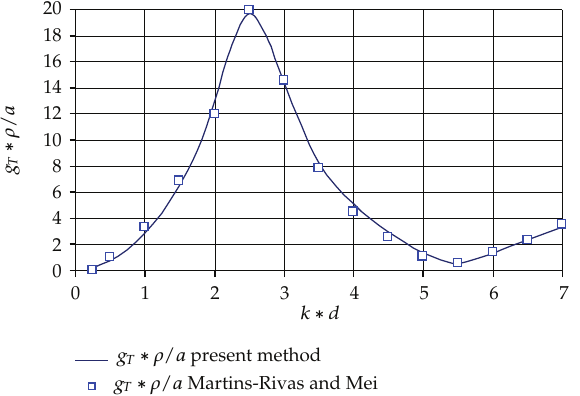
Figure 7: Optimum turbine parameter admittance g T · (cid:4) ρ/a (cid:5) versus kd .